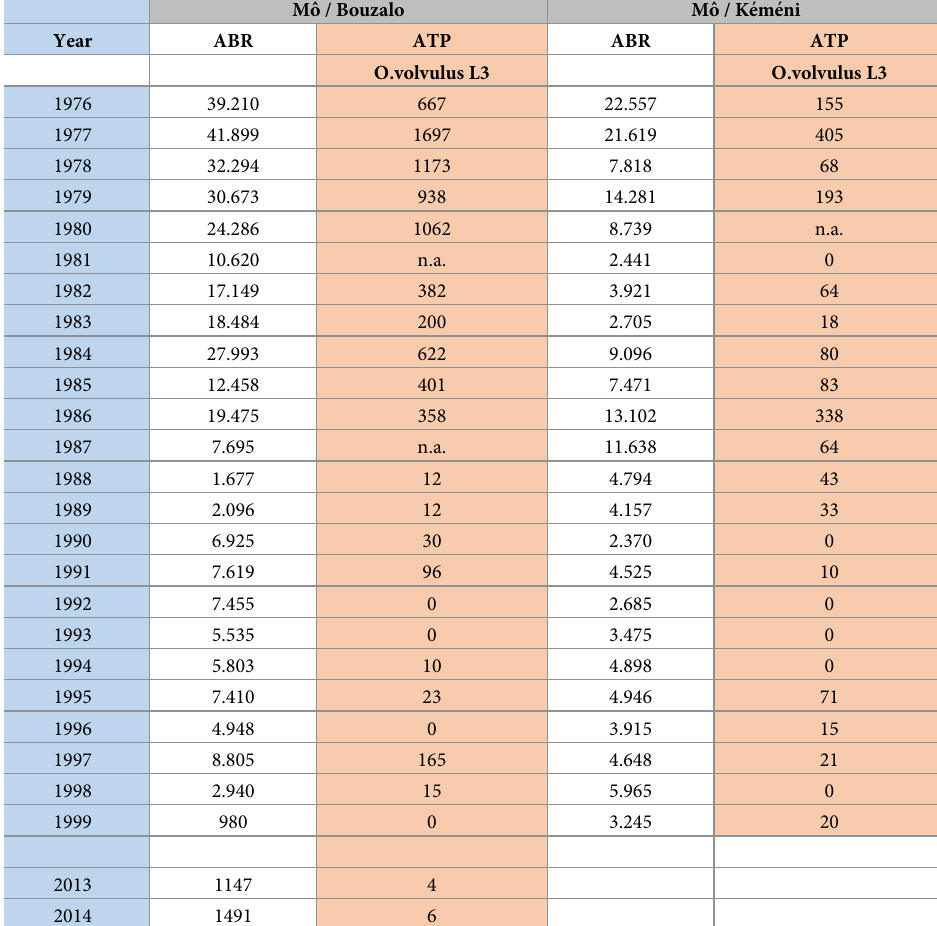
1491 and obstructs their release from gravid adult worms for several months [3–6,8]. Adult O . vol- vulus worms can live in infected humans within the nodules for over 15 years, necessitating a prolonged treatment course of ivermectin. Owing to the short lifetime of ivermectin and the absence of macrofilaricidal effects ivermectin treated O . volvulus infected and skin mf-negative individuals will harbour living adult worms. After ivermectin treatment fully developed intra- uterine mf will not be able to actively emerge from the uterus of female O . volvulus and will degenerate in utero. In adult female worms the intrauterine mf production and mf release is reduced, but reversible 9–12 months after ivermectin treatment. Reproduction of the parasite continues with regular insemination and normal embryonic development, and since this pro- cess is not synchronized several gravid female O . volvulus with different developmental larval stages can be found in the same nodule, and mf will continue to emerge. Thirty years of